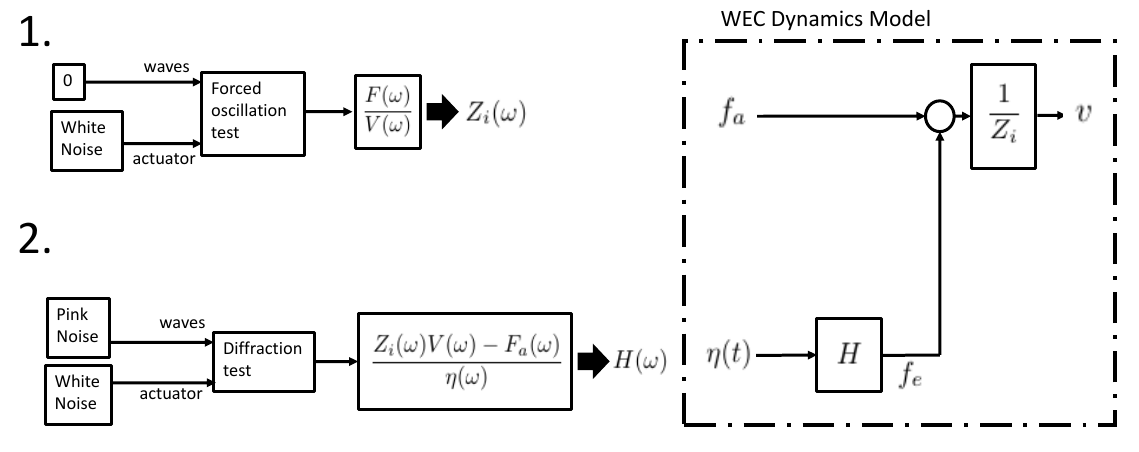
Fig. 1: System identification workflow used for WaveBot (adapted from [16]).